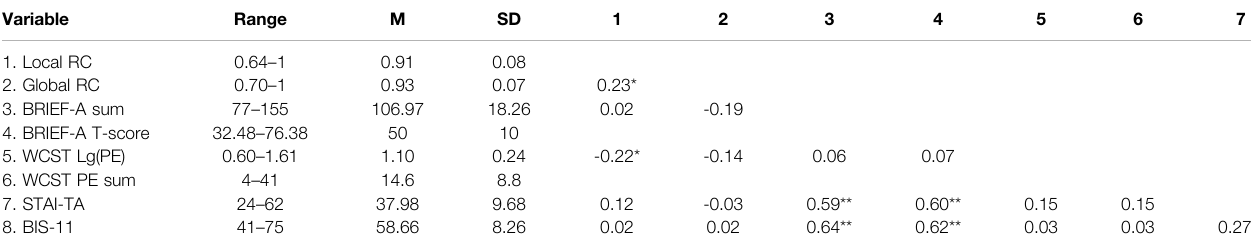
TABLE 1 | Descriptive statistics 1 and Spearman correlations for the research variables.